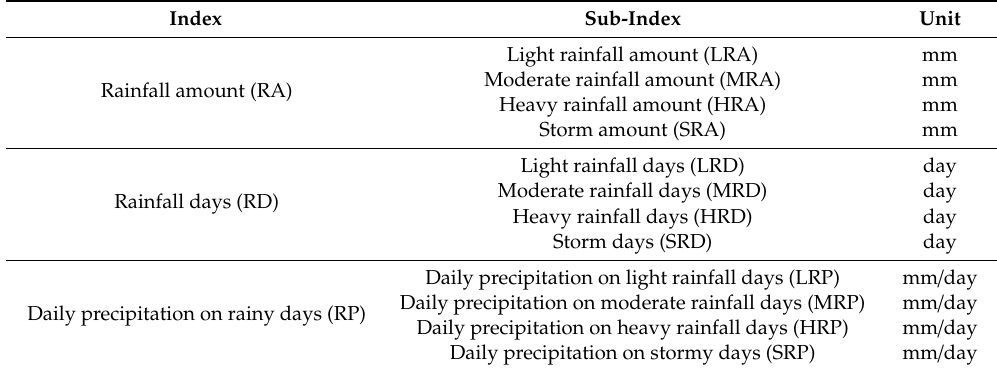
Table 2. Precipitation indices considered in this